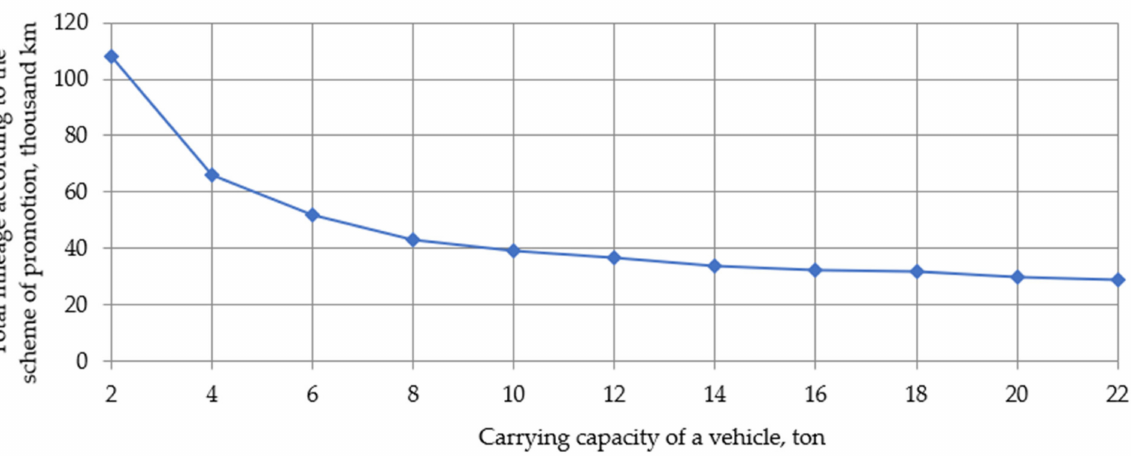
Figure 7. Change in the total mileage of vehicles according to the distribution scenario depending on its load